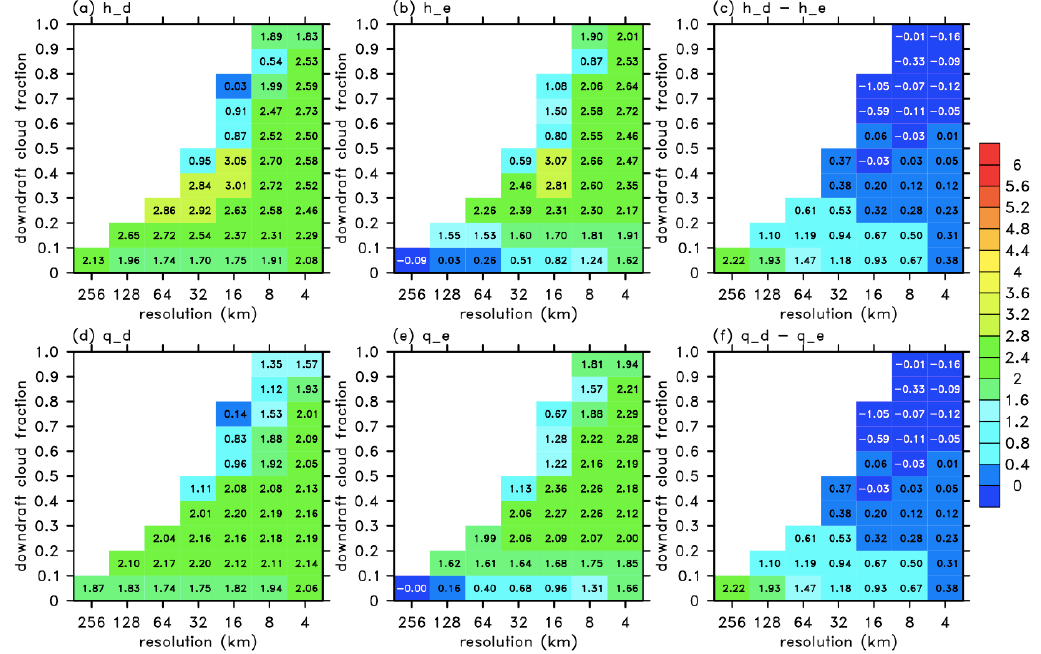
Figure 9. Moist static energy and specific humidity (K) in ( a,d ) downdrafts, ( b,e ) environment, and ( c,f ) their difference as functions of downdraft cloud fraction and subdomain size at the 500 hPa height.